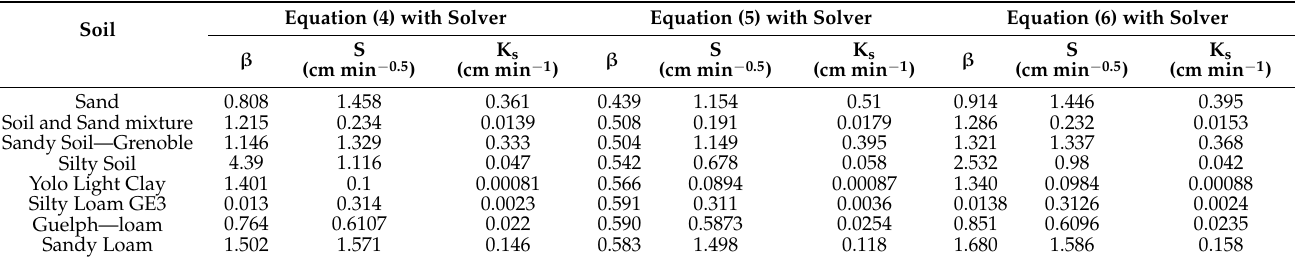
Table 4. Predicted values of S and K s from the complete Haverkamp (Equation (4)), two-term (Equation (5)) and three-term (Equation (6)) approximate expansions using the Solver application and considering β as an additional fitting